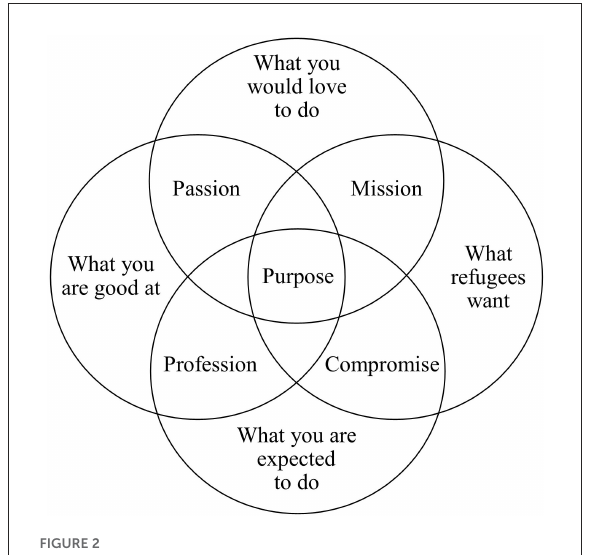
FIGURE2 Venn diagram for sport in refugee